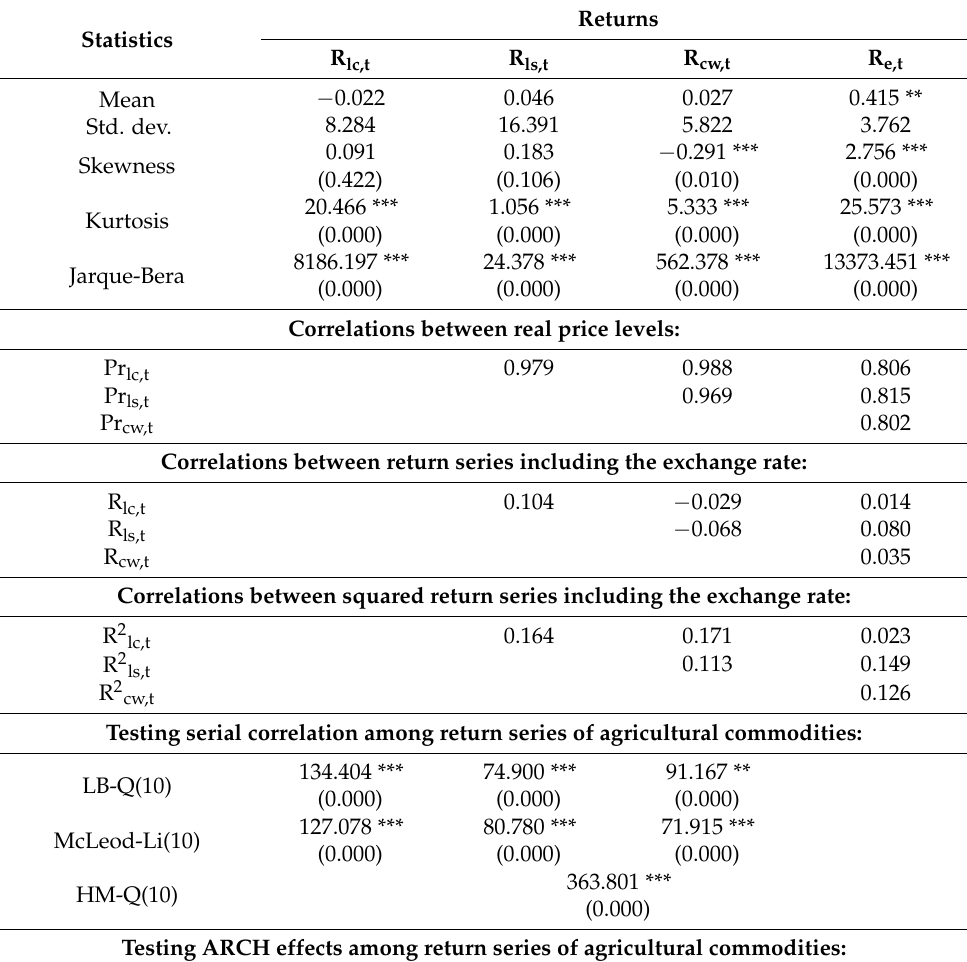
Table 1. Descriptive Statistics and Unit Root Test